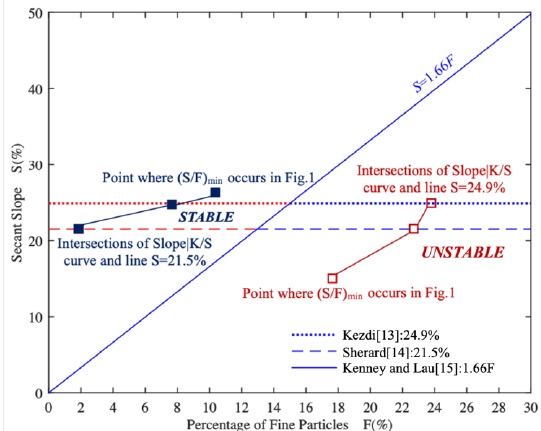
Figure 2. Synthetic chart for internal stability assessment of soils.